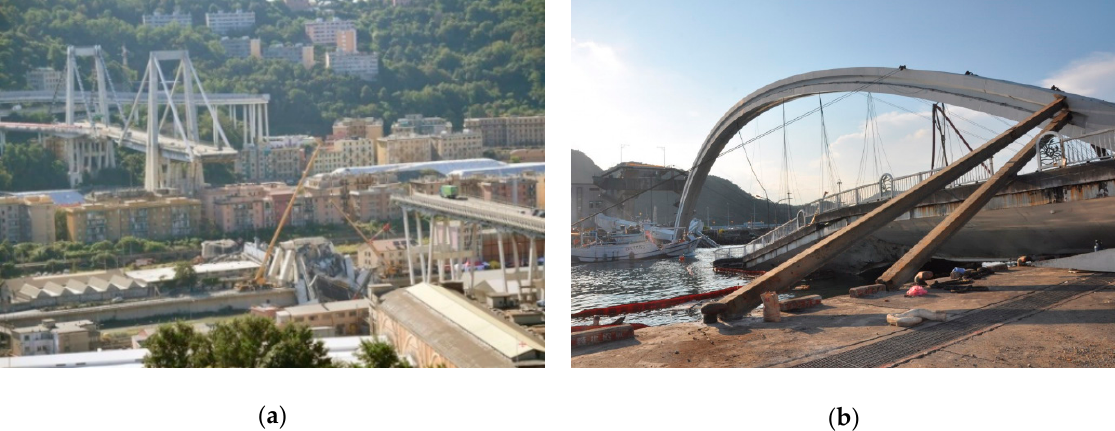
Figure 1. Examples of prestressed concrete (PSC) bridge collapse: ( a ) Morandi bridge (Italy, 2018) [1]; ( b ) Nanfang’ao bridge (Taiwan, 2019) [2].